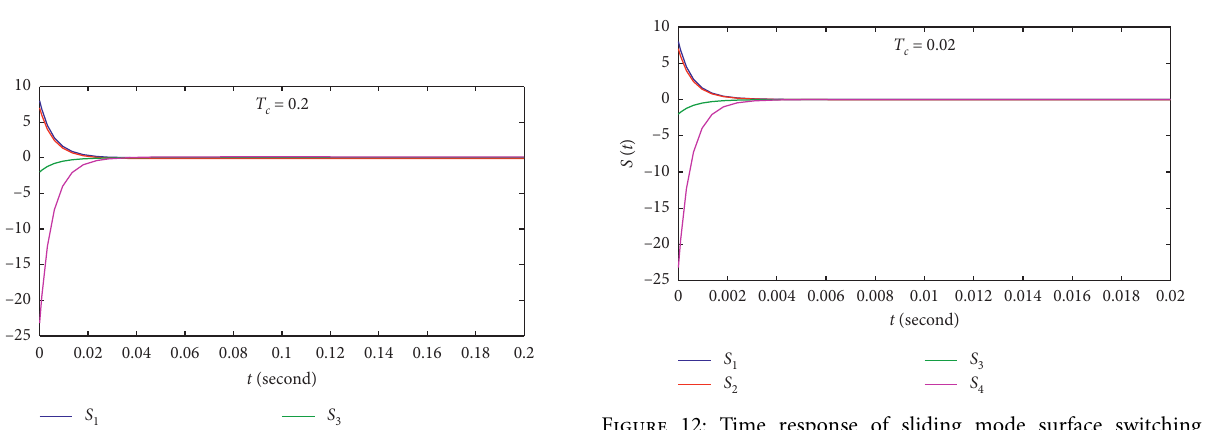
Figure 8: Comparison among the encrypted signal s ( t ) , the carrier signal K s x ( t ) , and the modulated signal w ( t ) .